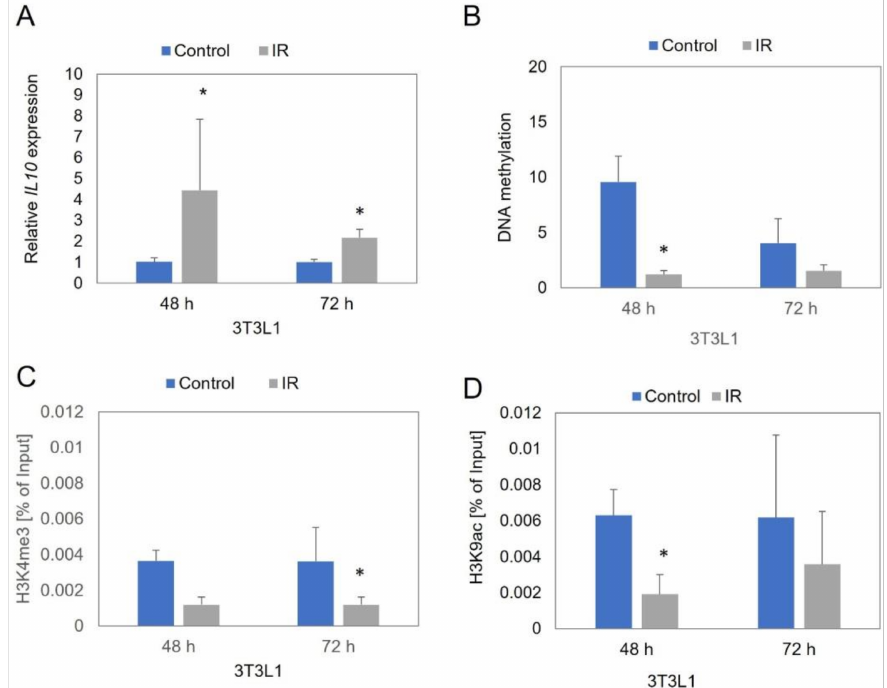
Figure 2. The IL10 expression ( A ), DNA methylation ( B ), histone methylation ( C ), and histone acetylation level ( D ) in control 3T3L1 adipocytes and in insulin resistant (IR) adipocytes after 48 and 72 h after insulin resistance induction. * p <